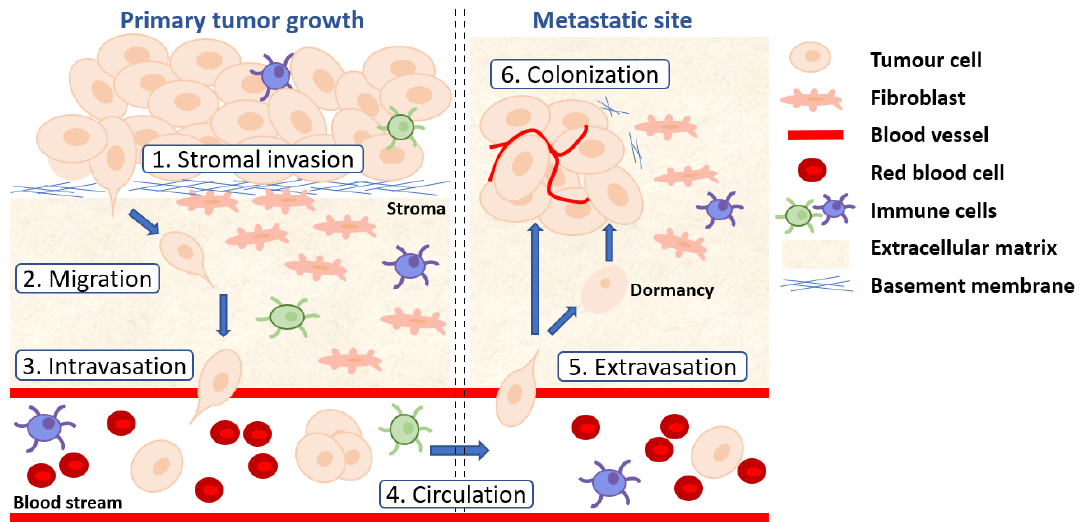
Figure 4. The metastatic cascade. ( 1 ) Tumor cells disseminate from the primary tumor site by invading through the basement membrane via proteolytic disruption of collagens and laminins. ( 2 ) Tumor cells adopt an EMT phenotype to migrate and invade through the surrounding stroma, breaking down the ECM. ( 3 ) Tumor cells enter the vasculature (intravasation) as single cells or as a cluster of cells. ( 4 ) CTCs survive in the circulation. ( 5 ) CTCs extravasate at distant sites through ruptured blood vessels. ( 6 ) Disseminated tumor cells colonize the metastatic site to form a secondary tumor by overcoming the harsh microenvironment, undergoing MET and establishing new vasculature. Alternatively, disseminated tumor cells enter a state of dormancy with potential to colonize.